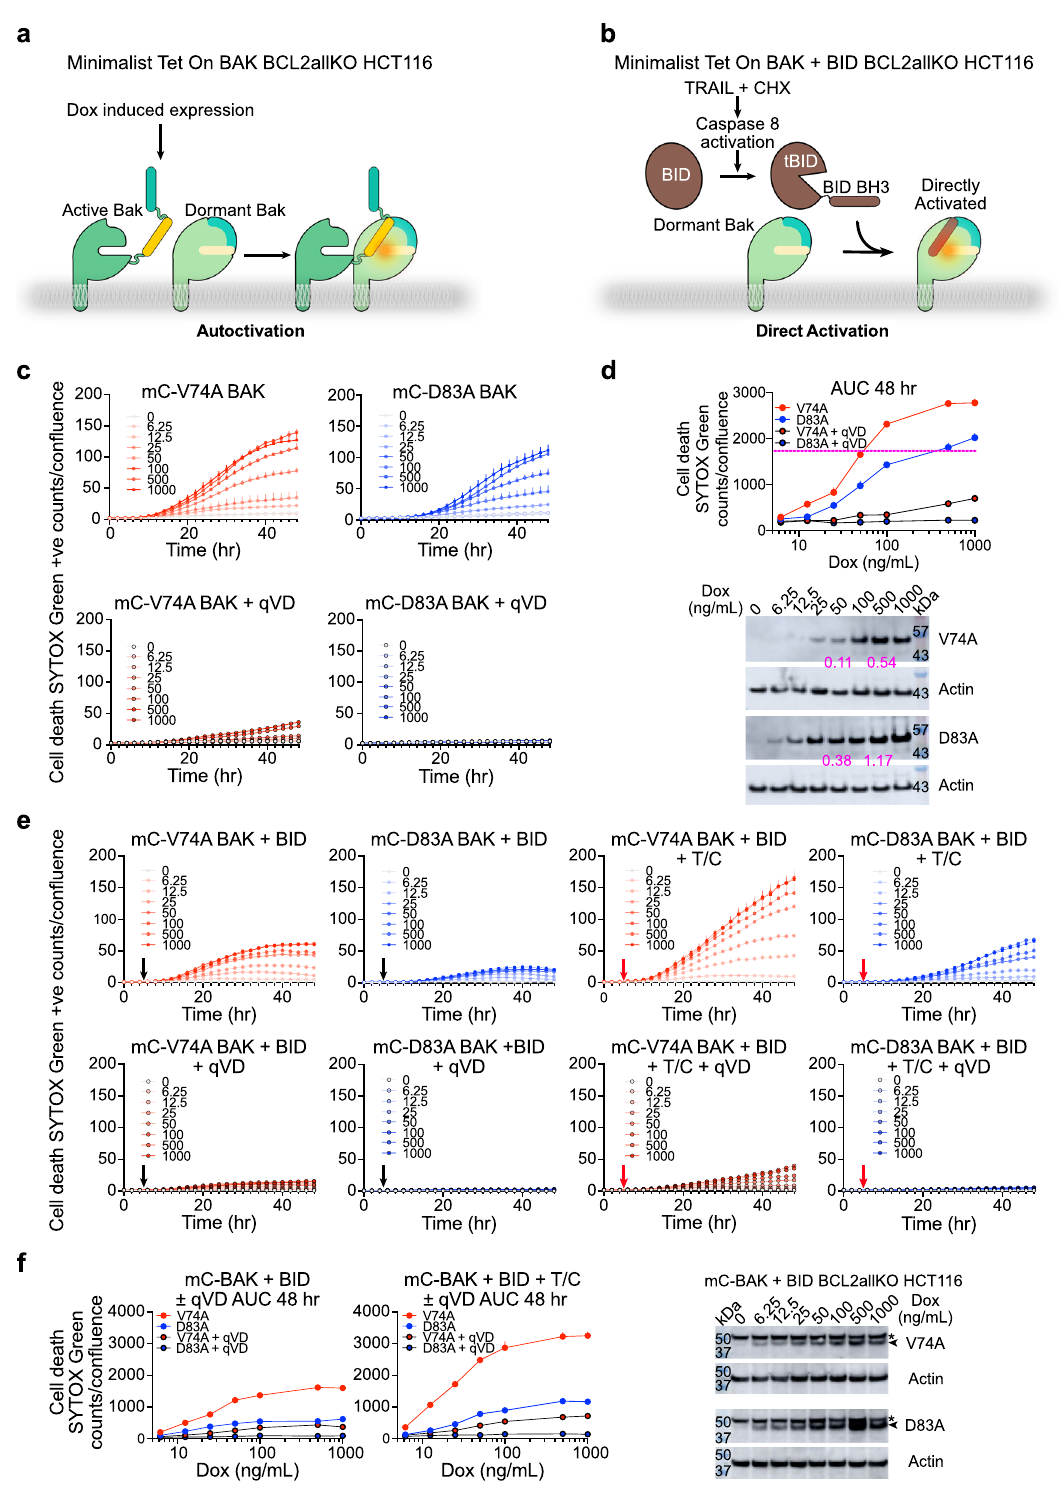
activation of a minor fraction of total BAK induces robust membrane permeabilization (Fig. 1d and Supplementary Fig. 3d, e). BH3 ligand-induced helix α 1 destabilization as the basis of direct BAK activation . Based on activity and binding pro fi les